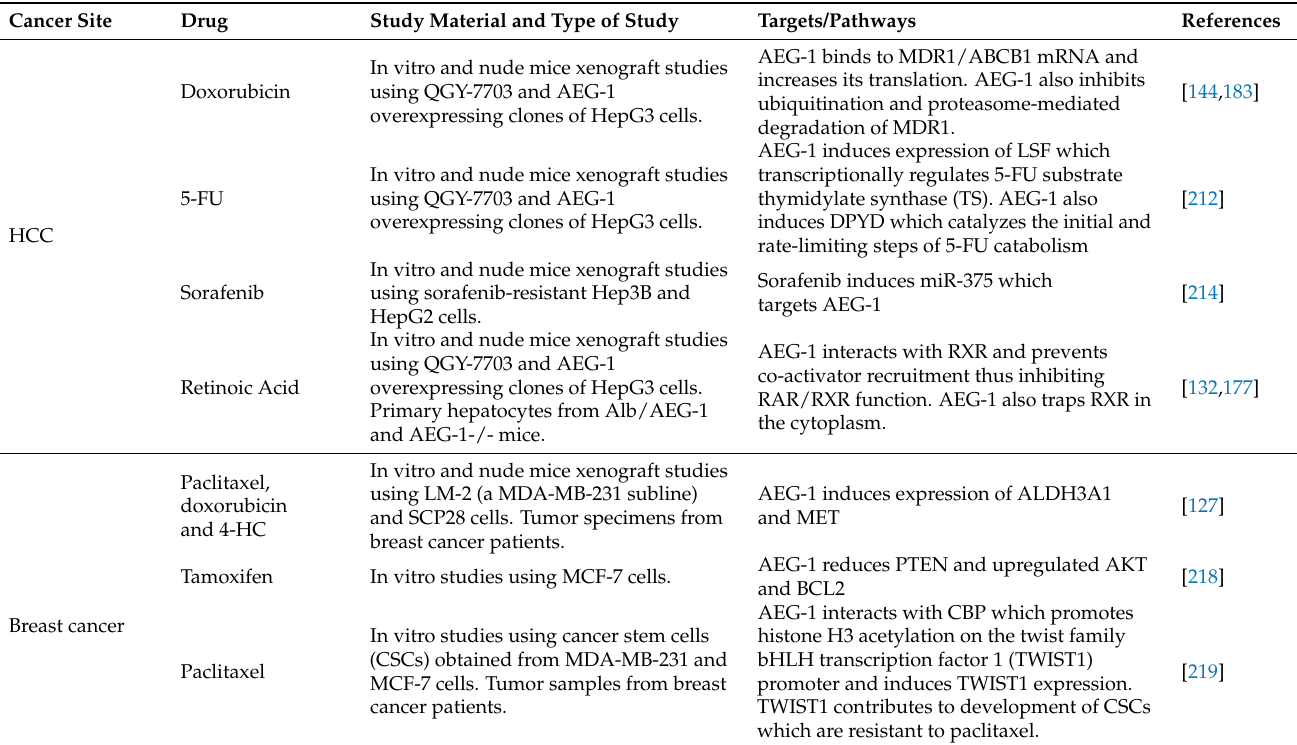
Table 2. AEG-1-mediated drug resistance in different